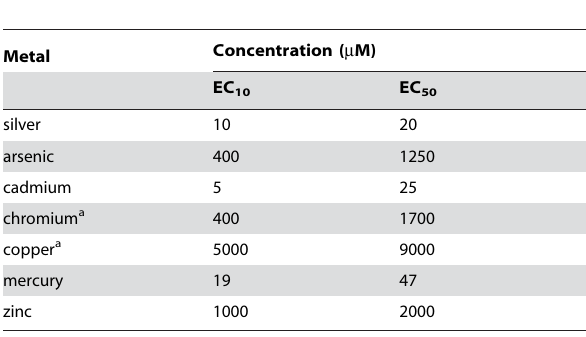
Table 4. Concentrations of metals used in microarray and deletion-strain growth